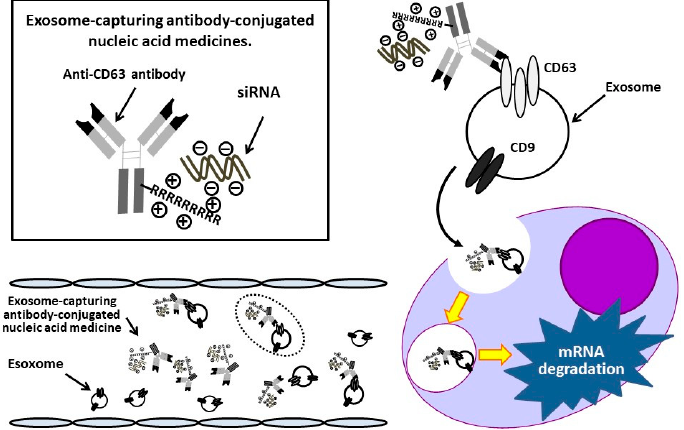
Figure 1. Schematic illustrating the concept of an exosome-capturing antibody-conjugated nucleic acid medicine. Antibody-conjugated siRNA complexes injected into the blood or bone marrow bind to exosomes by recognizing exosome surface antigen, CD63, and are taken up into multiple myeloma cells. Subsequently, the siRNAs bind to target mRNAs, leading to their degradation or inhibition of their translation, resulting in the suppression of myeloma cell proliferation.